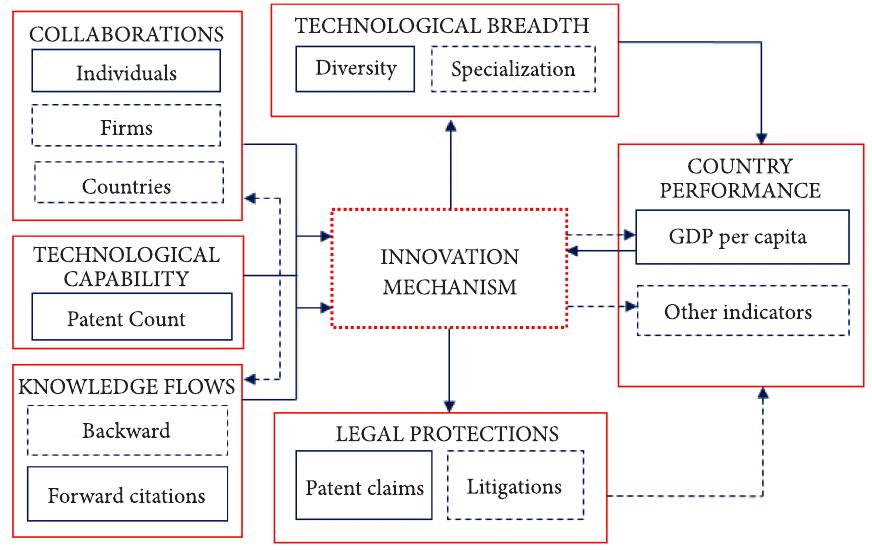
Figure 2. Methodological framework of